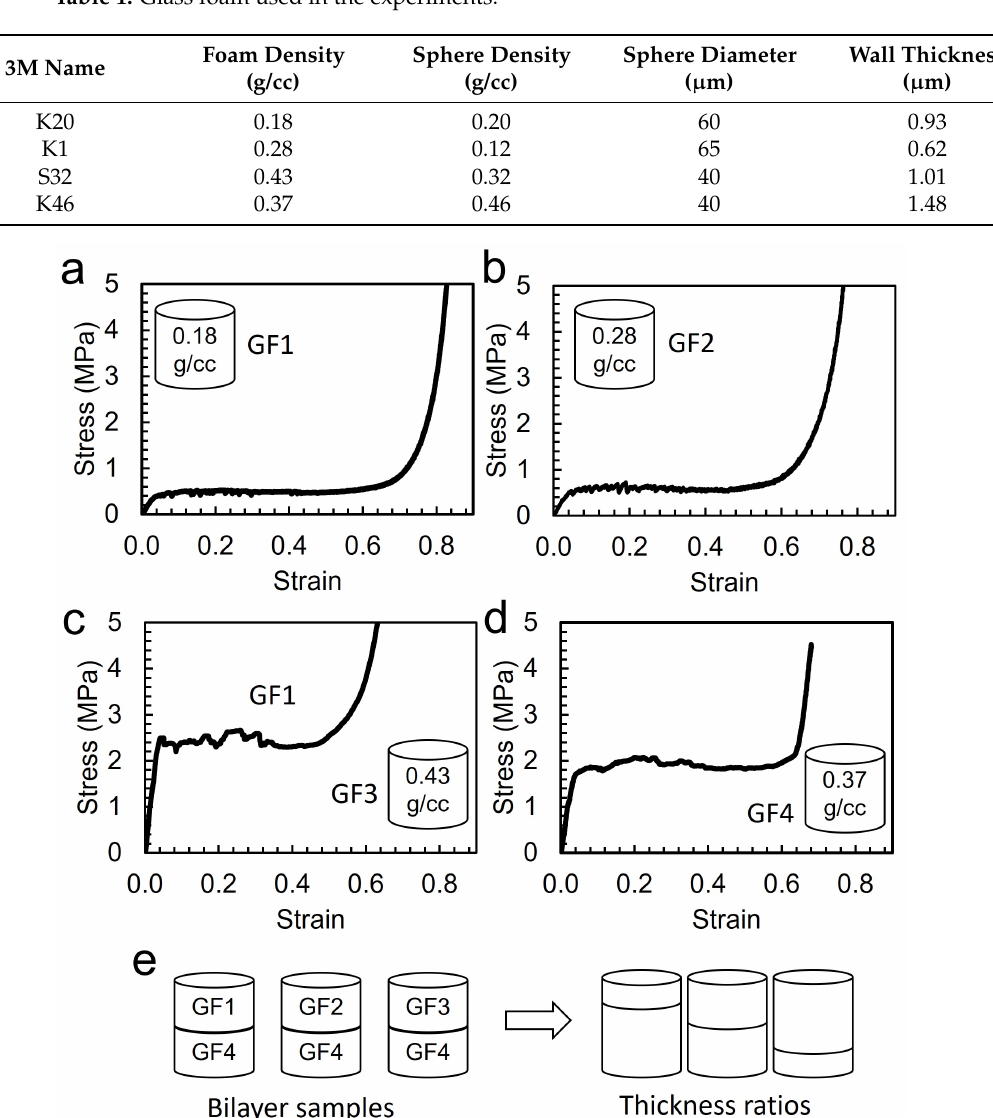
Table 1. Glass foam used in the experiments.